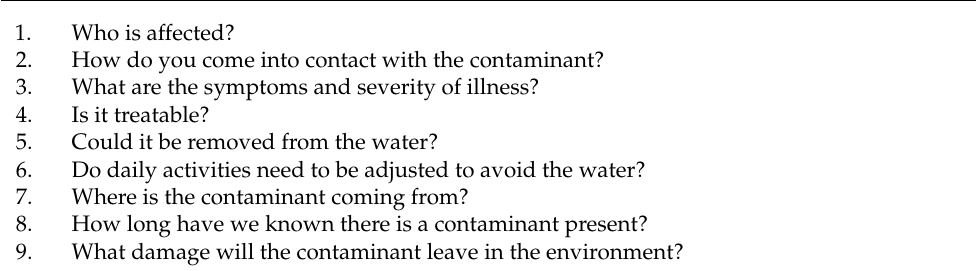
Table 4. Participants’ questions about the fictitious